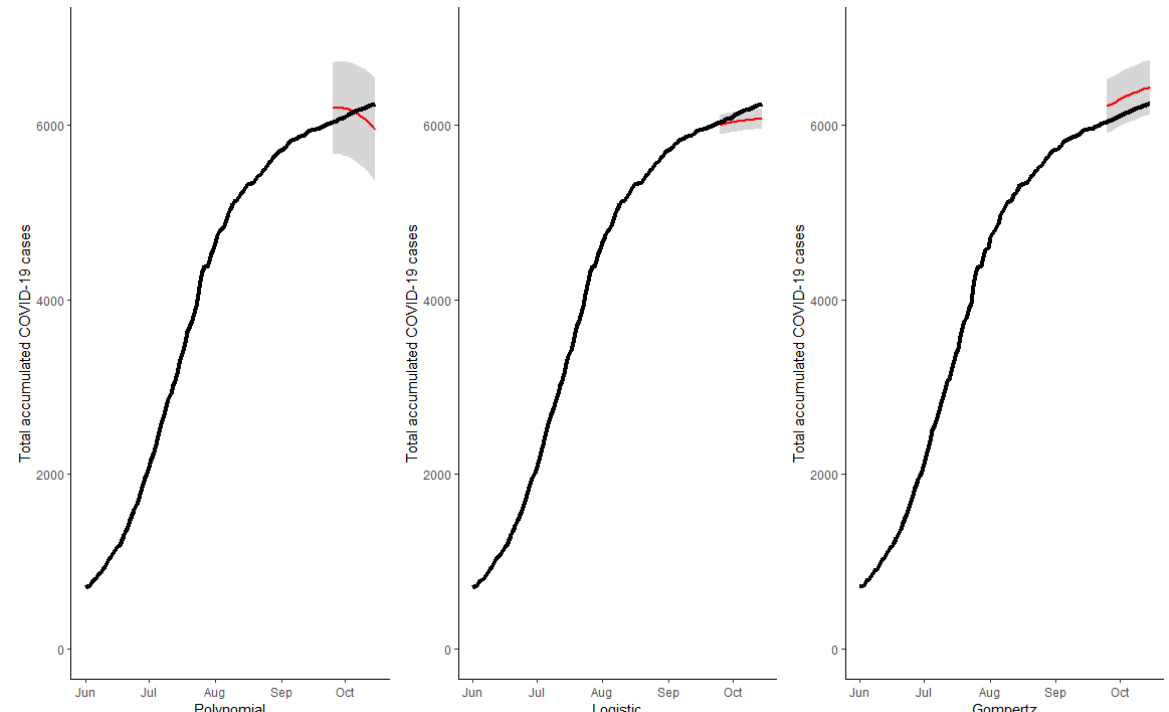
Figure 4. Forecast for total accumulated cases at 21 days for the state of Campeche.